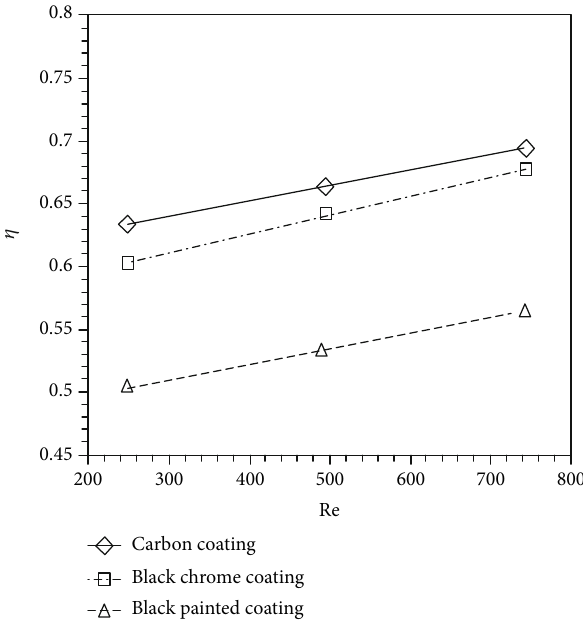
Figure 2: E ff ects of Reynolds number and coating materials on thermal e ffi ciency